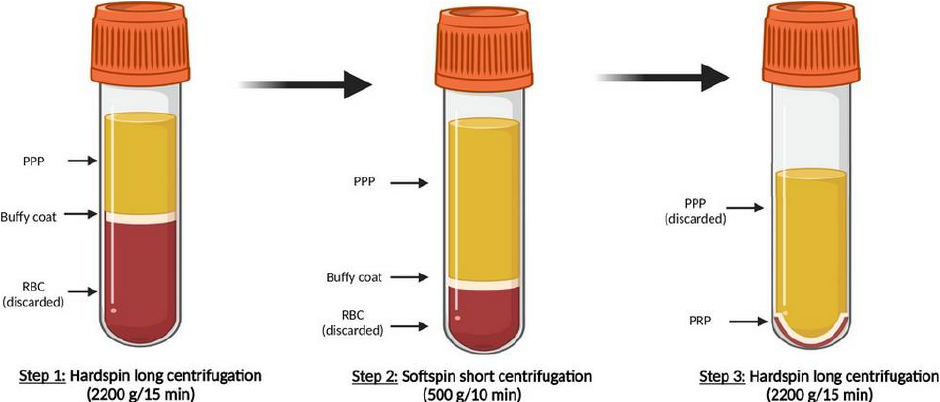
Figure 1. Schematic illustration of PRP preparation by three-step centrifugation method developed in our laboratory. (Created with BioRender.com). Abbreviations: RBC, red blood cells; PPP, platelet-poor plasma; PRP, platelet-rich plasma.